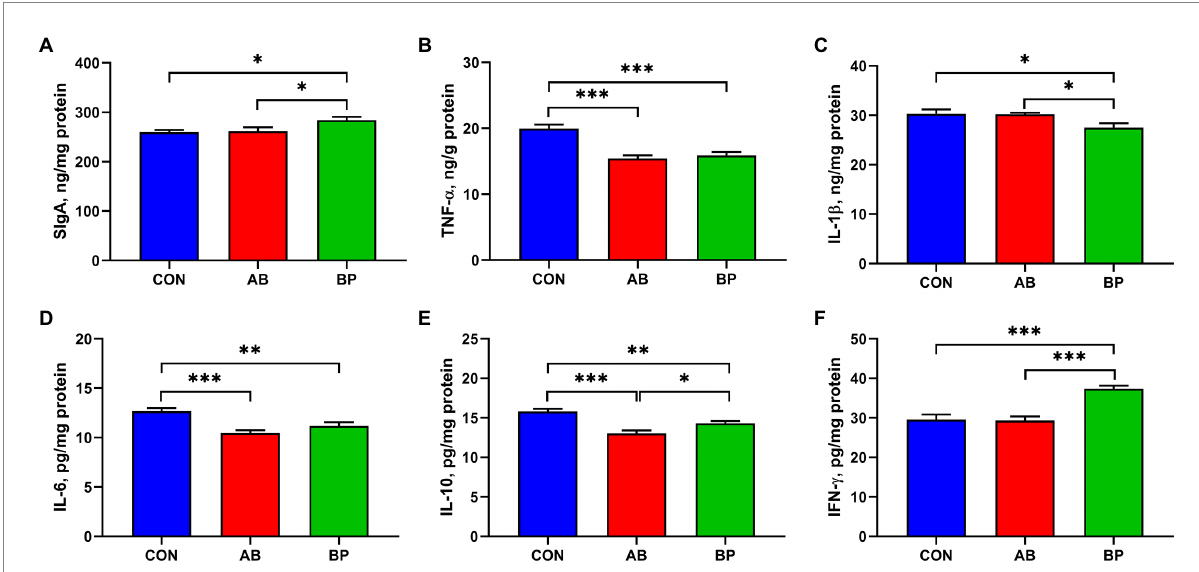
FIGURE 4 Effects of dietary supplemented with Bopu powder on Intestinal SIgA, inflammatory factors in broiler chickens. (A) Secretory immunoglobulin A (SIgA); (B) Tumor necrosis factor- α (TNF- α ); (C) Interleukin-1 β (IL-1 β ); (D) Interleukin-6 (IL-6); (E) Interleukin-10 (IL-10); and (F) Interferon- γ (IFN- γ ). CON group, broiler chickens fed a basal diet; AB group, broiler chickens fed a basal diet supplemented with 50 mg/kg aureomycin; and BP group, broiler chickens fed a basal diet supplemented with 40 mg/kg Bopu powder containing protopine and allocryptopine. Values are mean ± standard